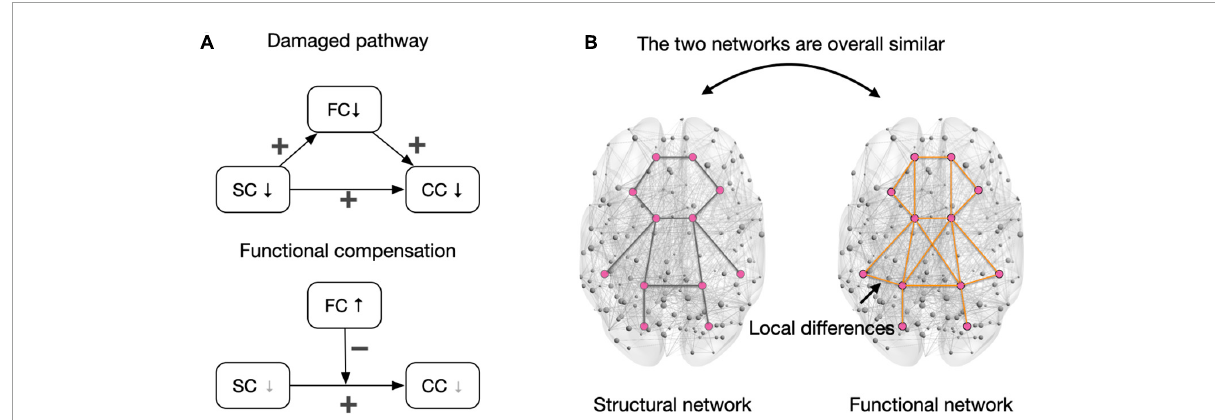
FIGURE2 Interactions of the functional and structural network in cognitive control. (A) The upper panel depicts the damaged pathway of “structural connectivity damage → functional connectivity damage → cognitive control decline” when the structural network damage is severe. Notably, the direct path (SC → CC) indicates a general relationship between decreased structural connectivity and cognitive control decline, and there may be other mediating variables beyond functional connectivity in maintaining this relationship. In the bottom panel, the gray downward arrow in SC indicates that the structural network is relatively intact or slightly damaged. In this case, the compensation of functional connectivity reduced the debilitating effects of structural connectivity damages on cognitive control. The gray downward arrow in CC indicates no decline (especially when the task is easy) or fewer declines in cognitive control when functional connectivity is compensated. The presentation of variable relationships followed the conventions in the multivariate model. (B) The structural and functional networks are generally similar, but functional connections can be built on tripartite structural pathways to retain connectivity (Suárez et al., 2020). This pattern (i.e., the structural and functional network are similar in whole but different in part) can be applied to the whole brain network. A relatively intact structural network is a prerequisite for compensating for functional connections. Pink dots represent brain areas, and lines between regions represent connections. SC, structural connectivity; FC, functional connectivity; CC, cognitive control; ↓ , decrease; ↑ , increase; +, positive relationship between two linked variables; –, increased FC diminishes the effect of structural connectivity damage in triggering cognitive control